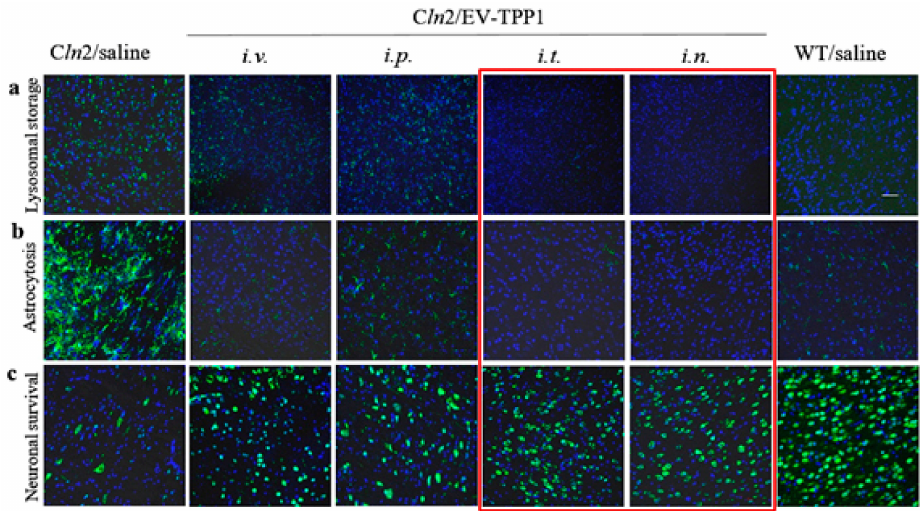
Figure 4. Therapeutic e ff ects of EV-TPP1 formulation administered via di ff erent routes in BD